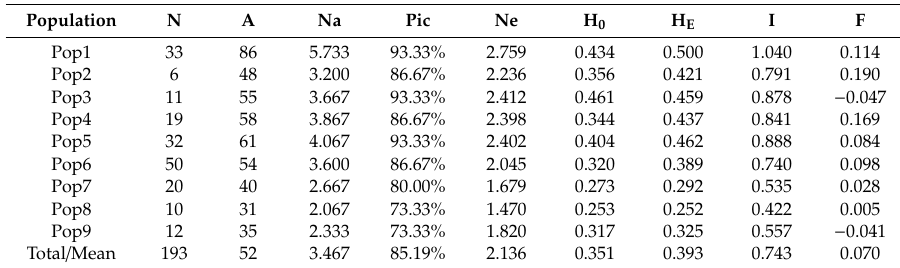
Table 4. Descriptive statistics of the overall loci for each population of A. marina : number of individuals (N), number of alleles (A), average number of alleles per locus (Na), percentage of polymorphic loci (Pic,%), number of e ff ective alleles (Ne), observed heterozygosity (H o ), expected heterozygosity (H E ), Shannon’s information index (I), and fixation index (F).